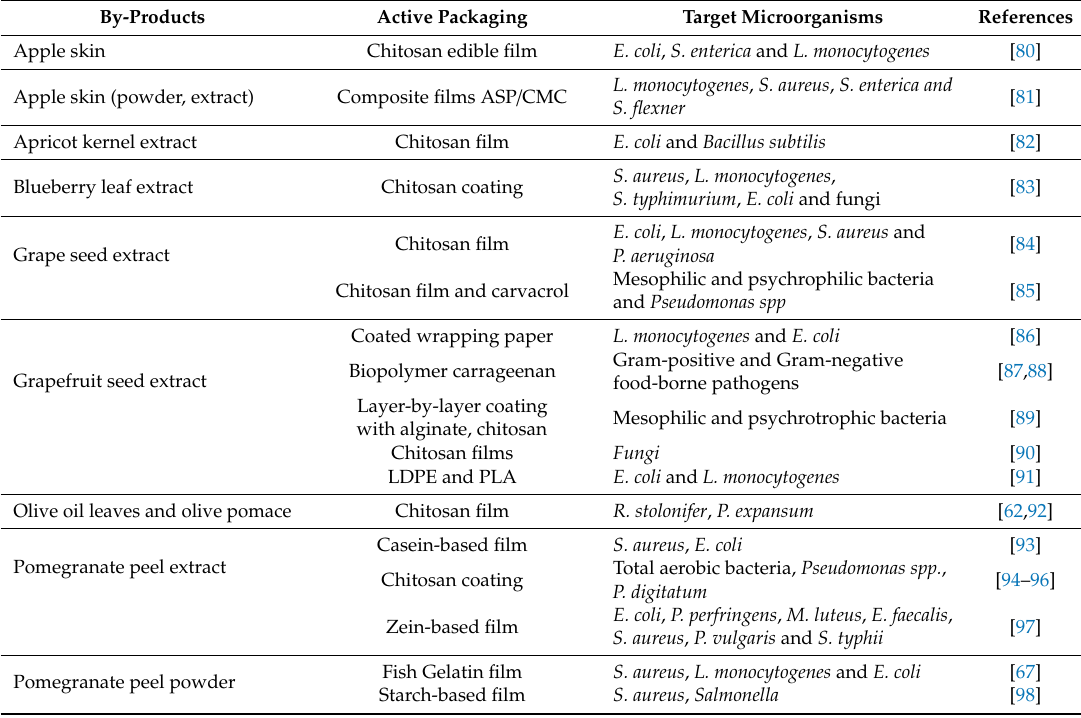
Table 2. Antimicrobial packaging with fruit and vegetable